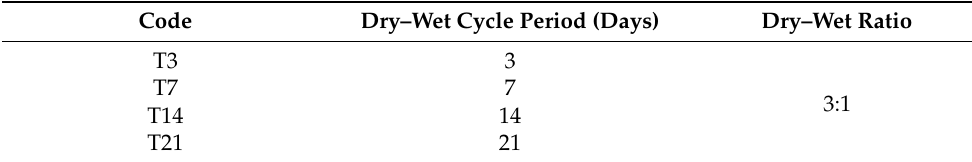
Table 3. Dry–wet cycle design.